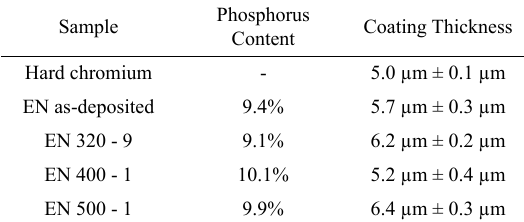
Table 1. Electroless Ni-P and hard chromium coatings